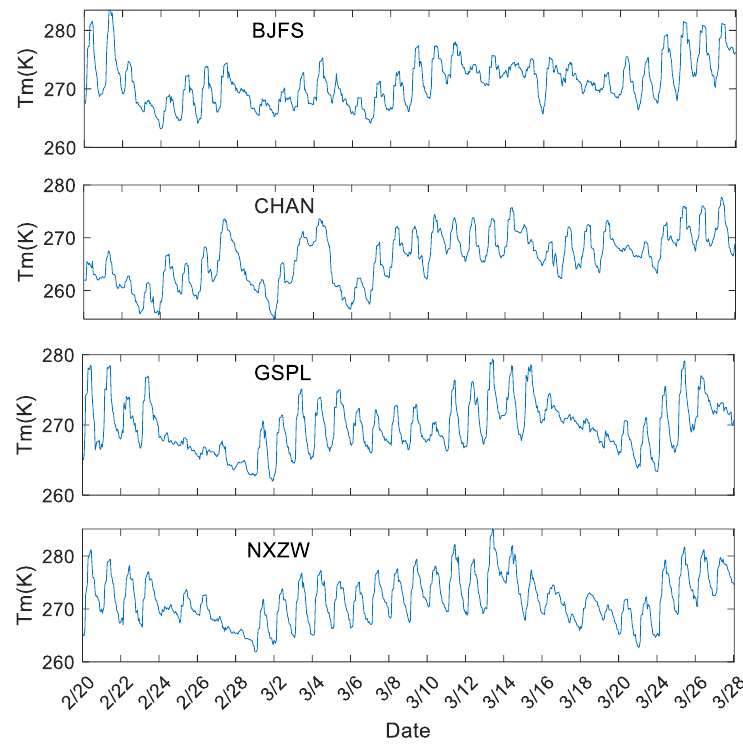
Figure 2. The 𝑇 𝑚 at four GNSS stations. Figure 2. The T m at four GNSS